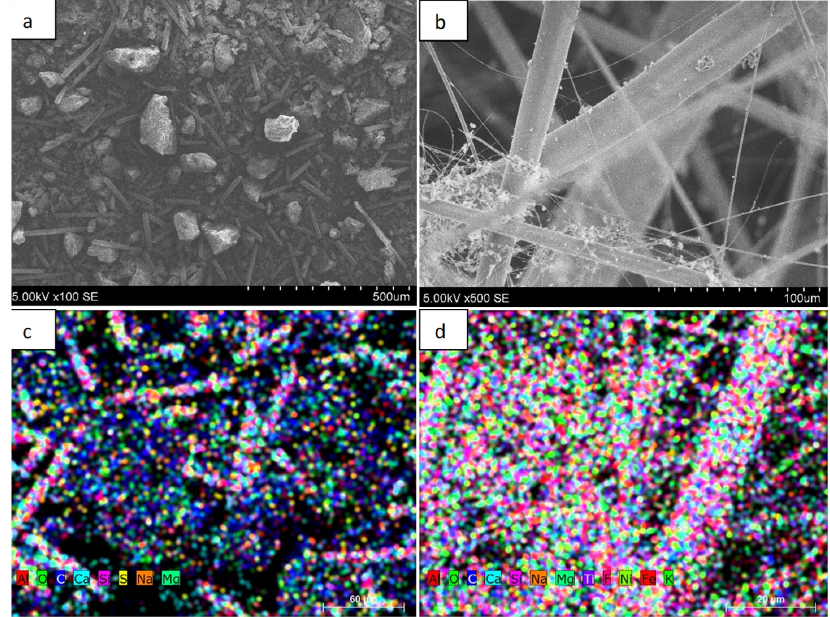
Figure 2. Images of wind turbine blade powder and fiber and distribution of elemental composition: ( a ) powder; ( b ) fiber; ( c ) distribution of the elemental composition of the powder; ( d ) distribution of the elemental composition of the fiber.